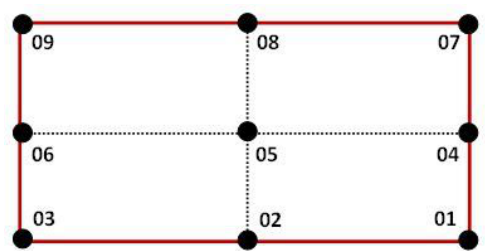
Figure 13: Identification of the points in the mesh for the generic receiver